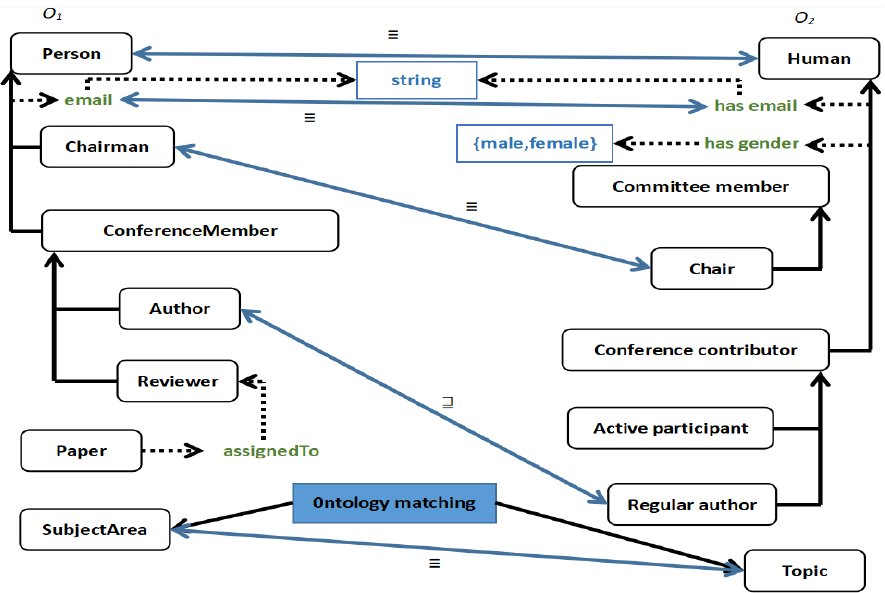
Figure 3. An Example of Heterogeneous Ontologies and Ontology